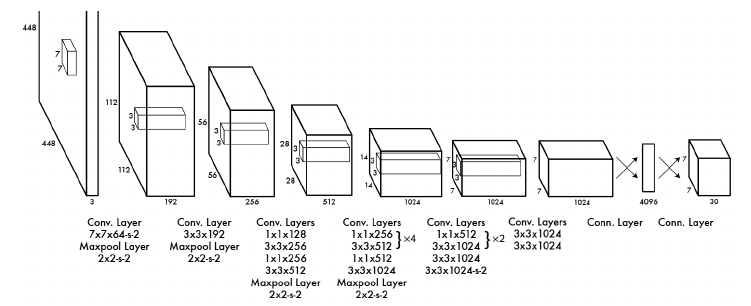
Figure 13. YOLO network architecture.